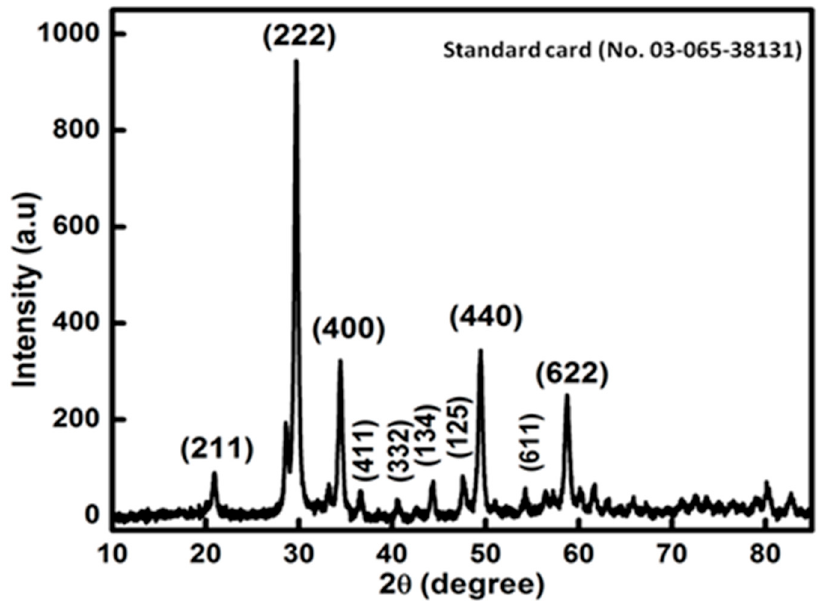
Figure 1. Typical XRD pattern of as-synthesized MPTMS@Gd 2 O 3 nanoparticles.